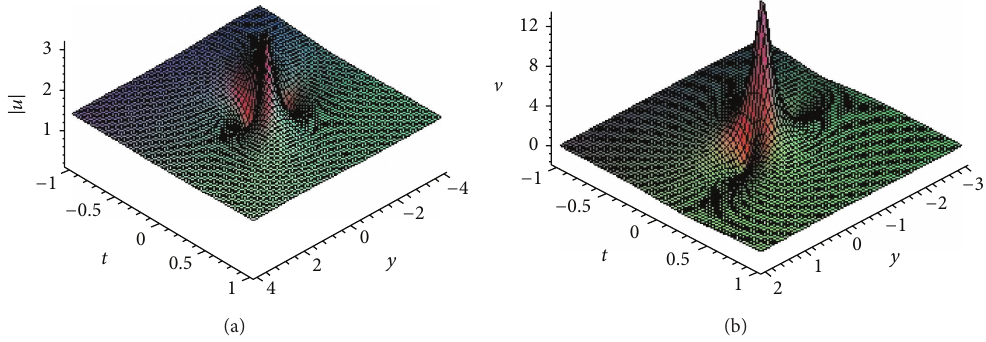
Figure 3: (a) Behaviour of |𝑢 2 | in solution (14). (b) Behaviour of V 2 in solution